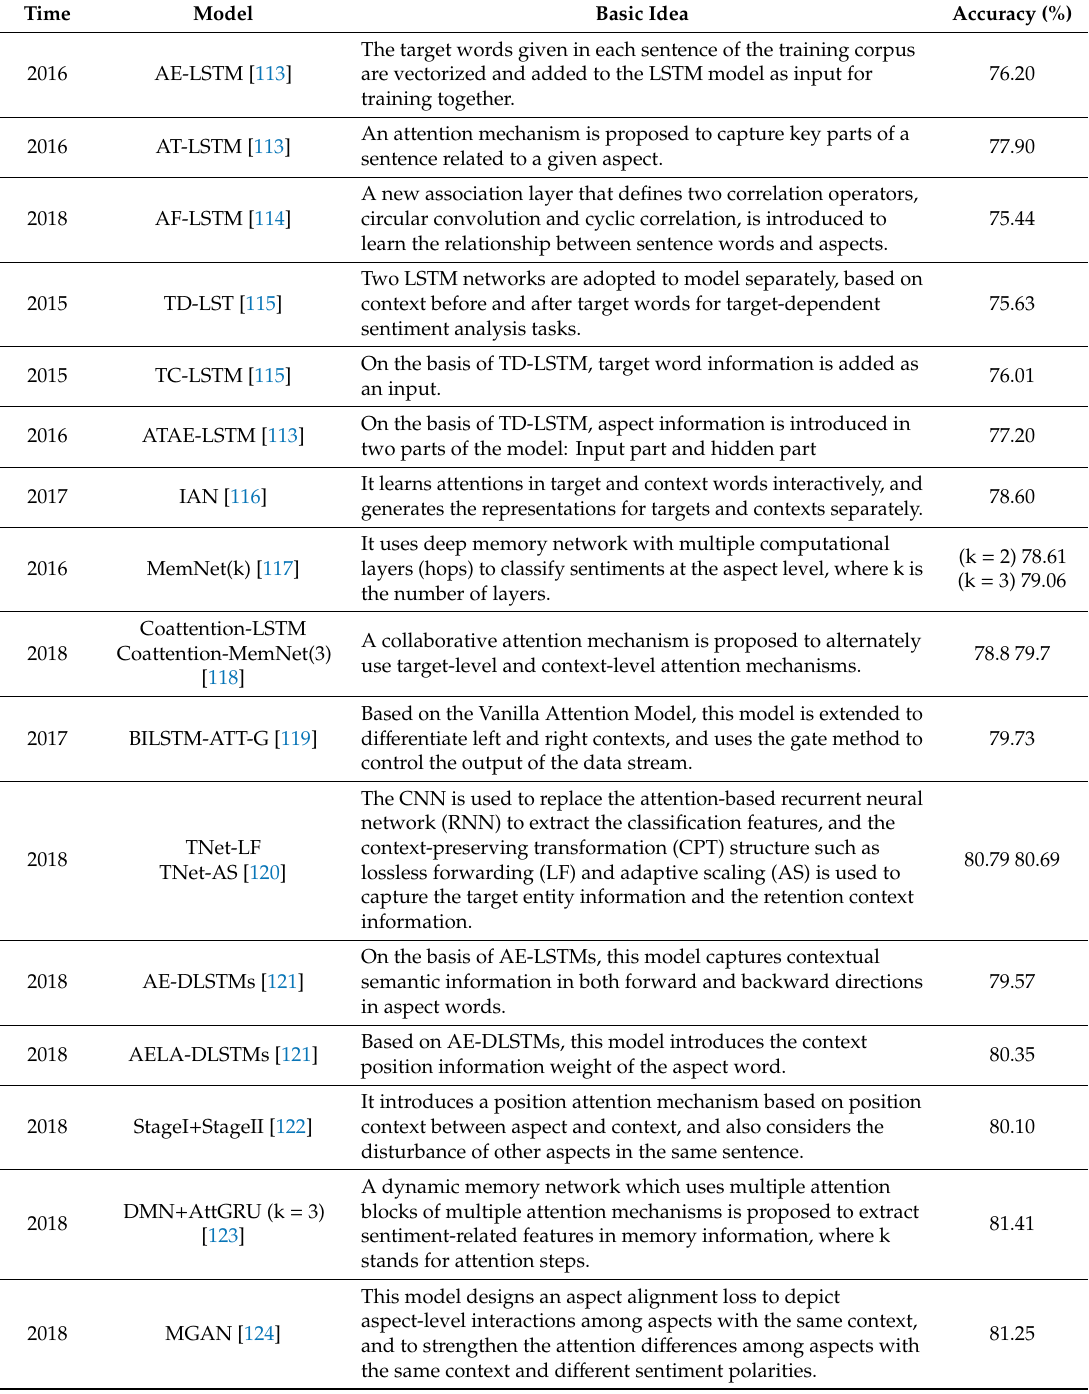
Table 4. Common aspect-based sentiment analysis (ABSA) and target-dependent sentiment analysis on SemEval 2014 Task 4 in restaurant